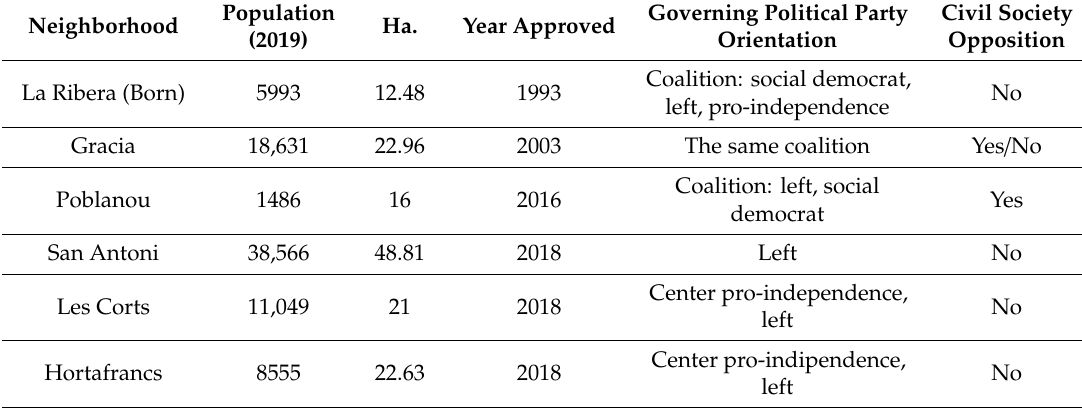
Table 1. Current Superblocks and features.